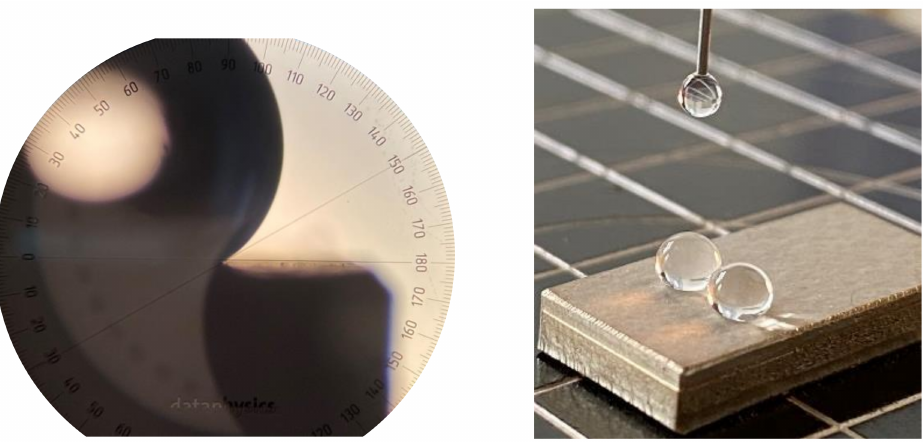
Figure 9. Hydrophobic behavior of water droplets on FAS coated fine porous stainless steel